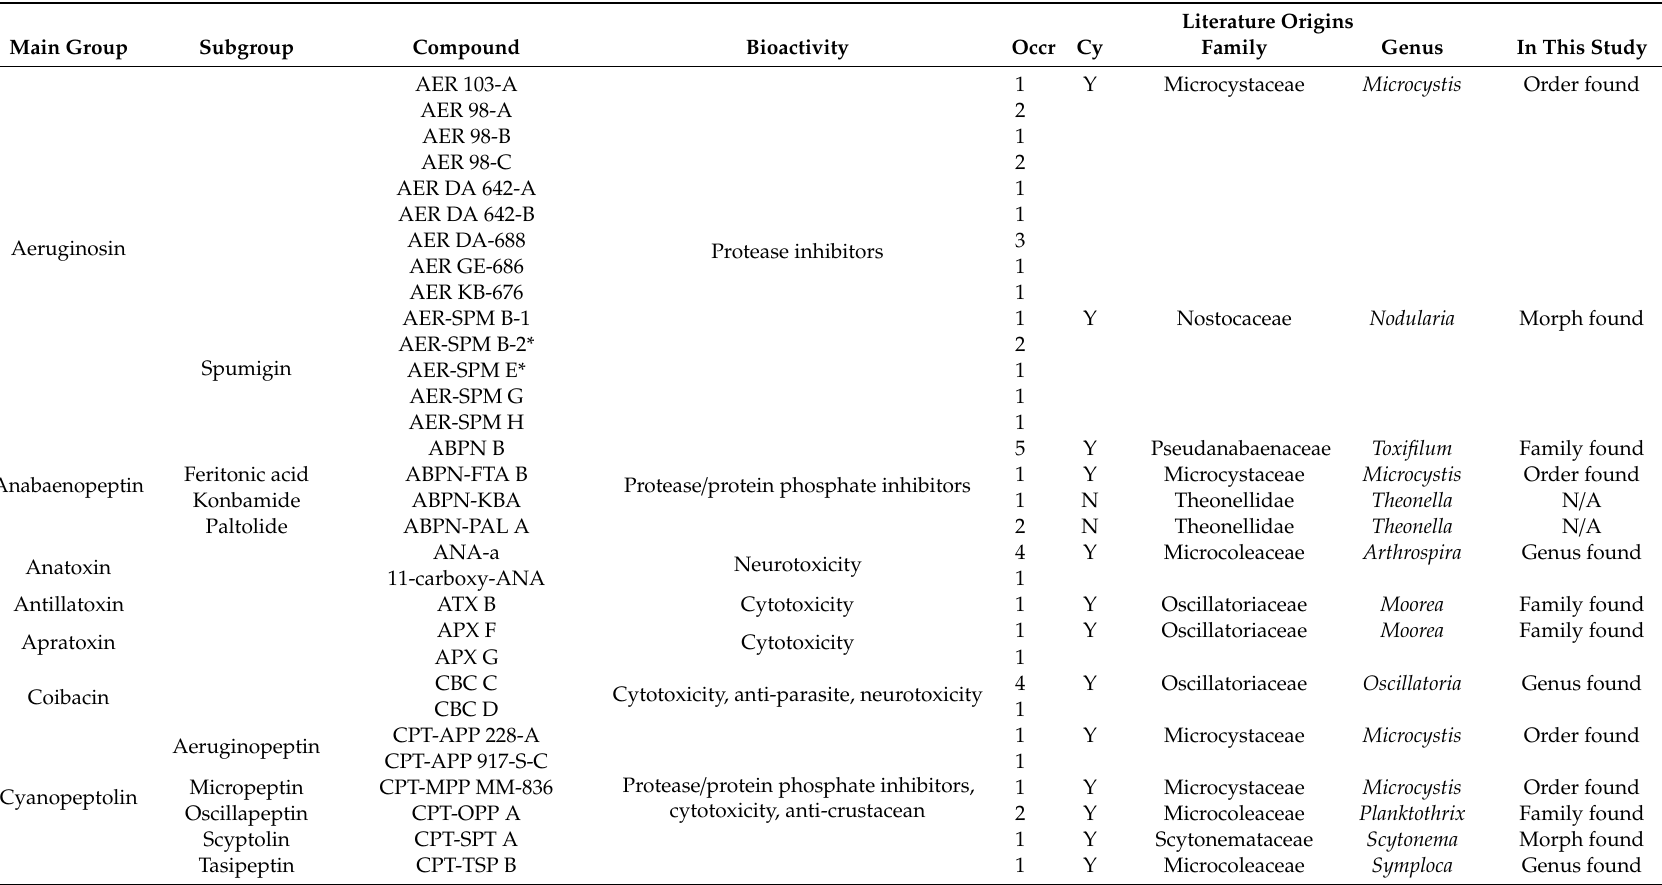
Table 3. HPLC Orbitrap results for Laguna Madre wind-tidal flat screening for all known cyanobacterial bioactive metabolites, organized as in Huang and Zimba (2019). Listed compounds had peak exceeding 10,000 area counts. Names followed by an asterisk were area counts exceeding 100,000, with a double asterisk indicating mass di ff erence equals 0 ppm. Occurrence (Occr) refers to how many samples (of 9 total) contained each toxin. Literature of metabolite origins was summarized